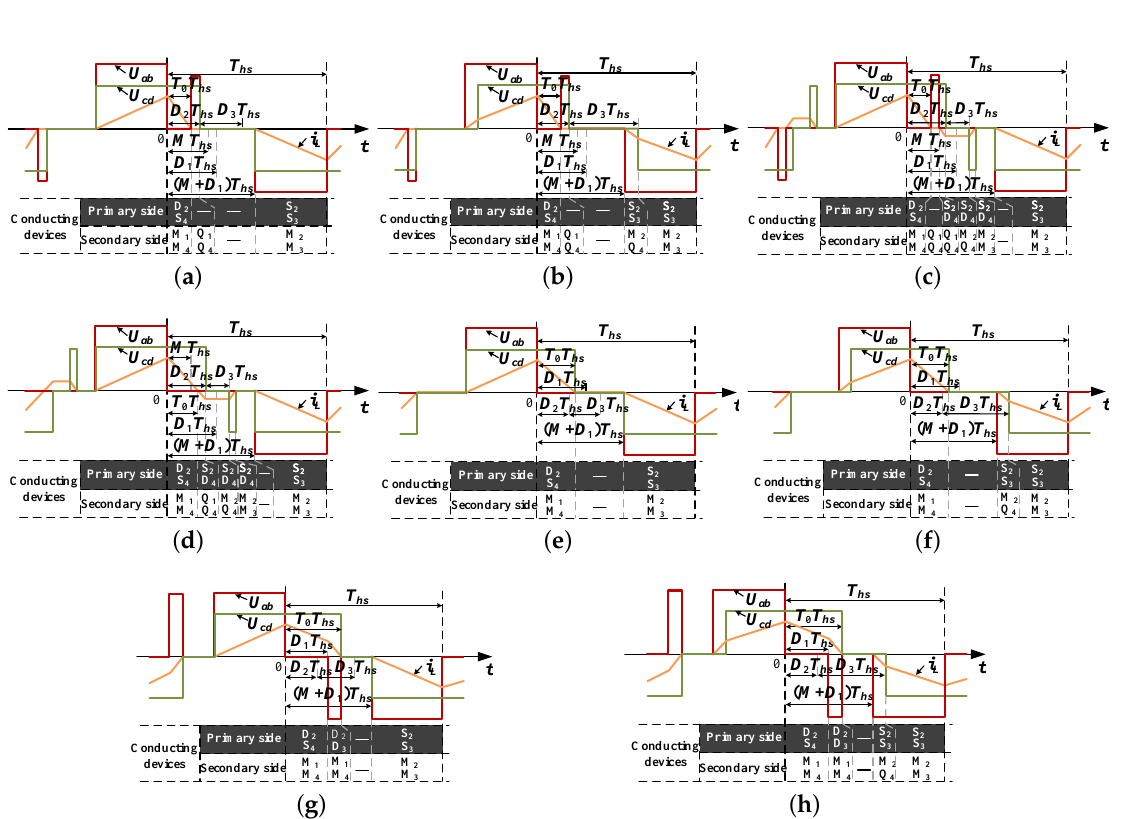
Figure 8. Waveforms of sub modes under M II : ( a ) M II1 ; ( b ) M II2 ; ( c ) M II3 ; ( d ) M II4 ; ( e ) M II5 ; ( f ) M II6 ; ( g ) M II7 ; and ( h ) M II8